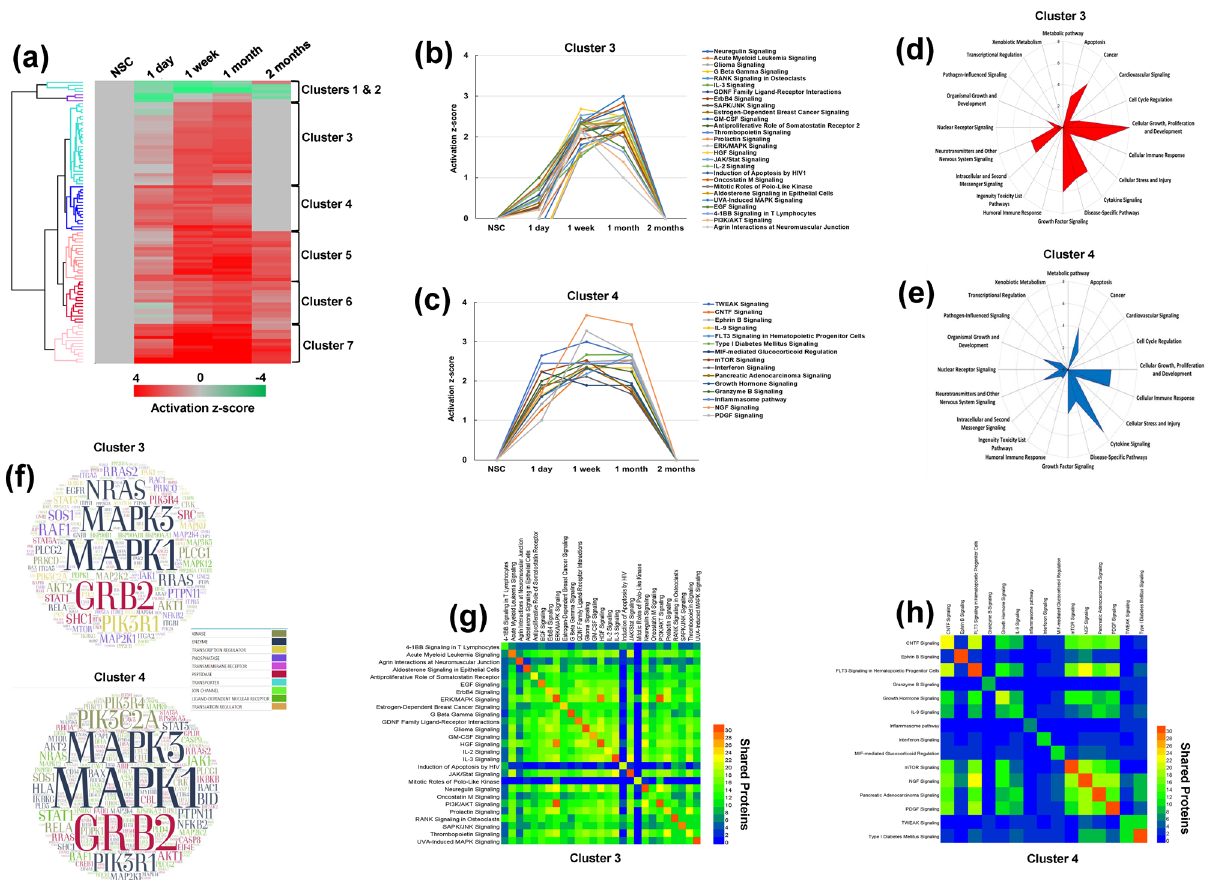
Figure 3. Temporal proteomic and in silico analyses of signaling pathway modulation in rat esophageal tissues following reconstruction with acellular grafts. ( a ) Heatmap and unbiased clustering of signaling cascades based on z-score activation over the course of esophageal healing. N = 4 animals were analyzed per experimental condition. Each column represents pathway status of NSC or neotissues at experimental timepoints. Red = activated, Green = inhibited, Grey = baseline normalized to nonsurgical controls (NSC). The heatmap was generated using pHeatmap package (v1.0.12) in RStudio (v1.3.1093) detailed at http:// www. rstud io. com/. ( b,c ) Line charts of activation z-scores of pathways contained in Clusters 3 ( b ) and 4 ( c ). ( d,e ) Radar graphs of significantly activated pathways Clusters 3 ( d ) and 4 ( e ) demonstrating biological functions. ( f ) Word clouds showing the most recurrent proteins and their functions in pathways identified in Clusters 3 [top plot] and 4 [bottom plot]. ( g,h ) Heatmaps showing the level of internal connectivity (shared proteins) between pathways in Clusters 3 ( G ) and 4 ( h